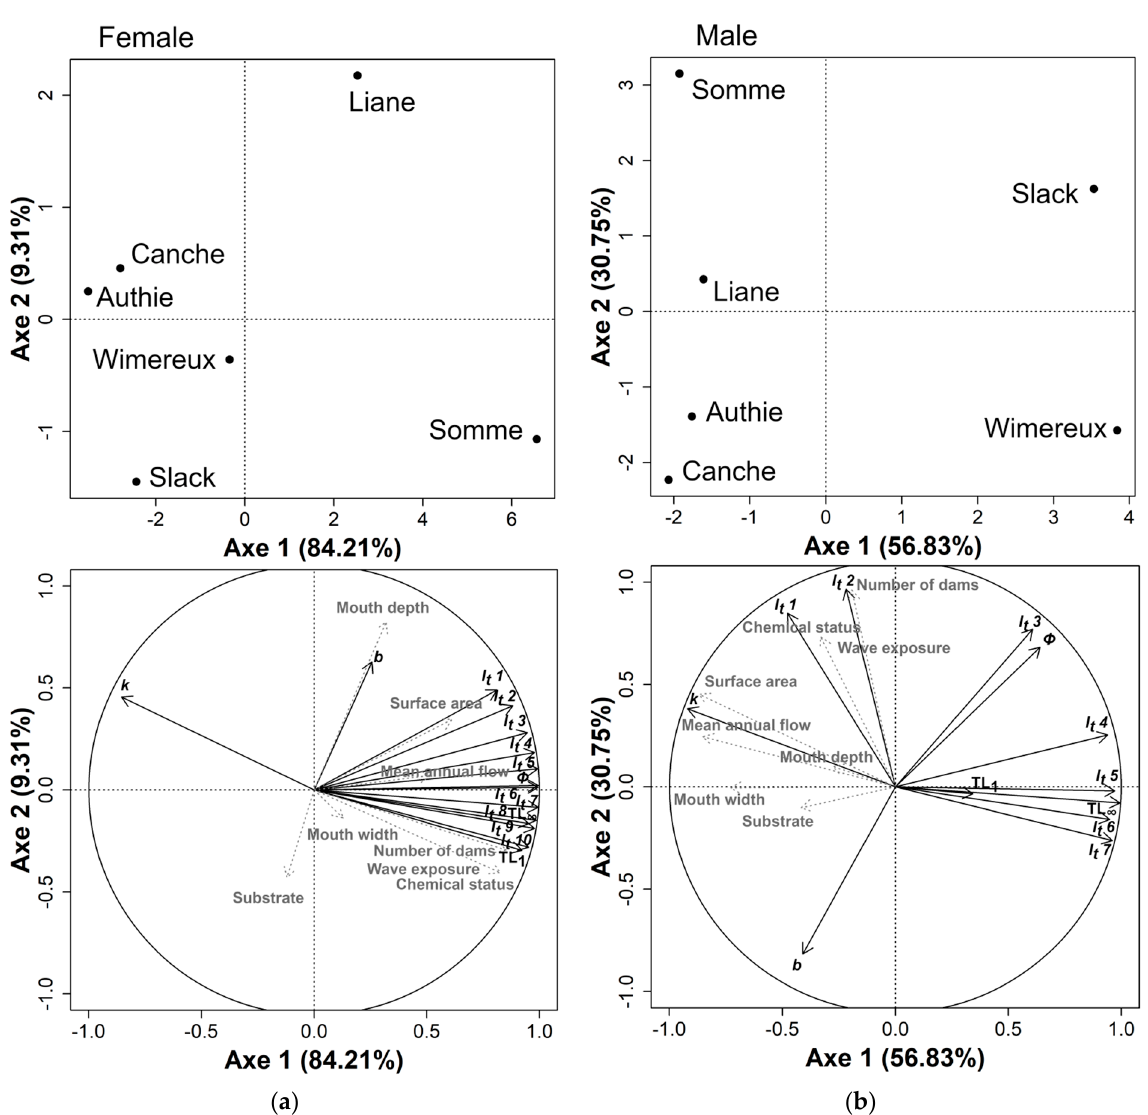
Figure 6. Observations ( top ) and correlation circle ( bottom ) of the first two axes of the Principal Component Analyses (PCA) on the growth of ( a ) female and ( b ) male eels ( b , TL ∞ , k , TL 1 , Φ , and I t ; black arrows) in the six estuaries as a function of the hydro-morpho-sedimentary (surface area, mean river annual flow, wave exposure, mouth depth and width and substrate; grey arrows) and anthropogenic (number of dams and chemical status; grey arrows)